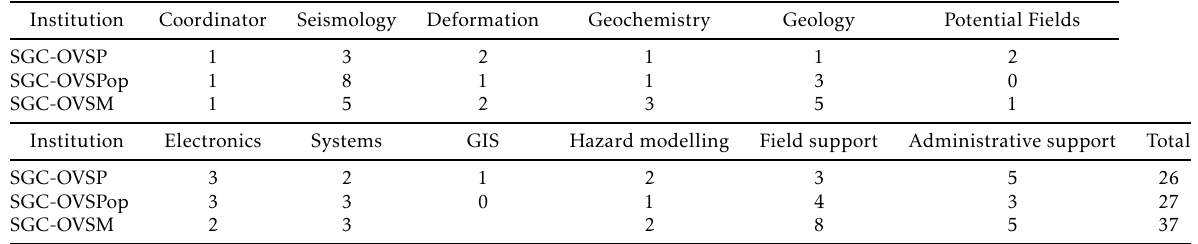
Table 3: Staff distribution by thematic areas, for the three Observatorios Vulcanológicos y Sismológicos (OVS) in charge of research and monitoring of the active Colombian